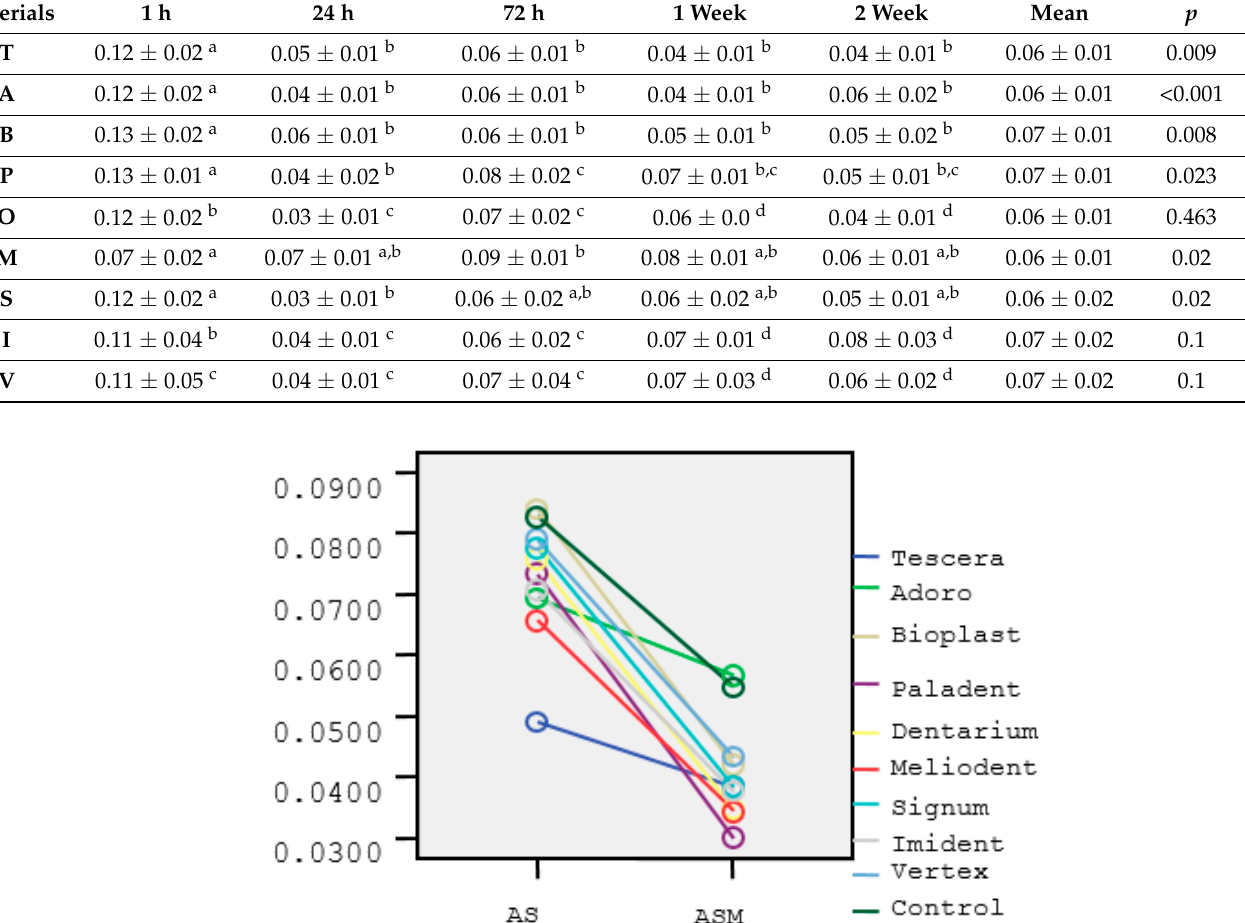
Table 4. The mean and standard deviations of absorbant index level per material in artificial saliva with melatonin in (ASM). Different letters a,b,c,d in the same column indicate significant differences ( p < 0.05). See Table 1 for group abbreviations.